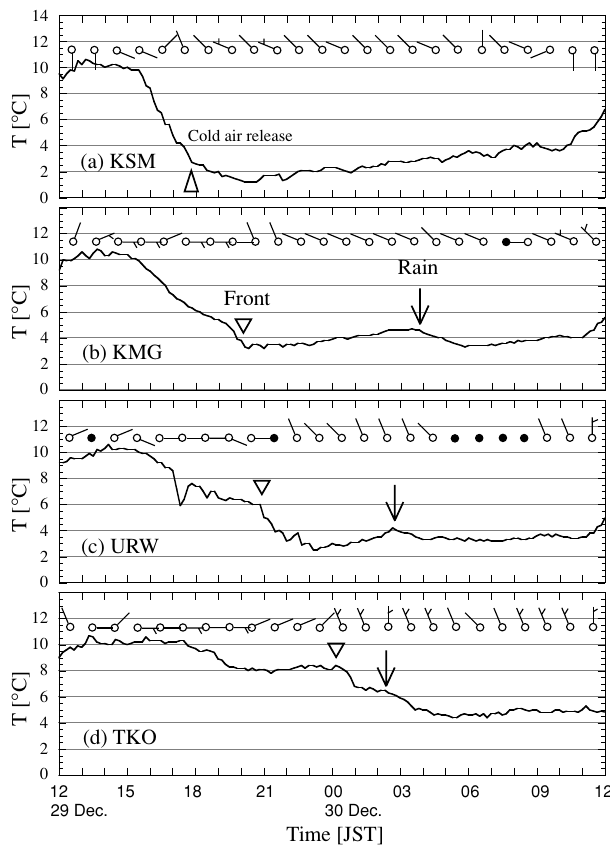
Fig. 5. Time series of the surface wind vectors and temperature recorded at ( a ) Kamisatomi, ( b ) Kumagaya, ( c ) Urawa and ( d ) Tokyo from 12:00 JST on 29 December to 12:00 JST on 30 De- cember 1997. The upward pointing triangle in (a) indicates the time of the start of the cold air release. The downward pointing triangles in (b)–(d) indicate the arrival time of the front, while the downward pointing arrows show the starting time of precipitation. The wind barbs are hourly means and are plotted at the middle of the hourly interval. The temperature values are 10-minute means, plotted at the end of the time